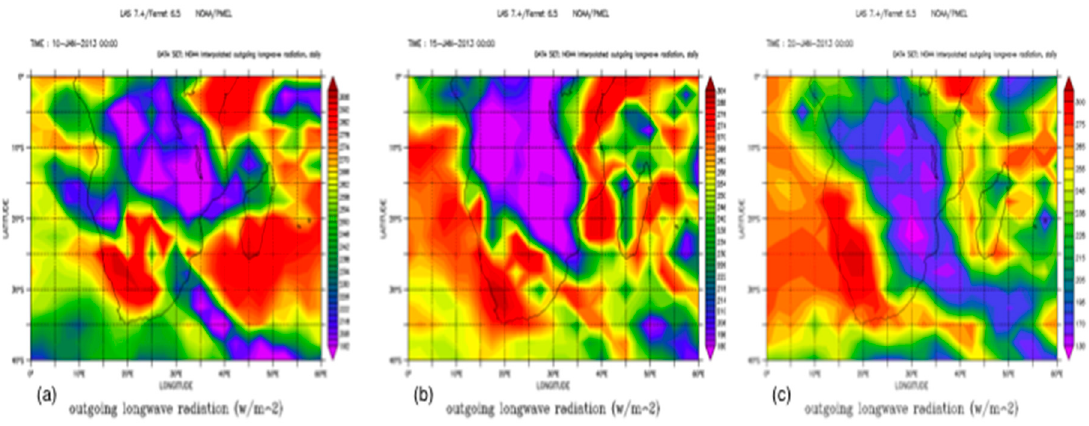
Figure 7. Outgoing longwave radiation (W m − 2 ) (http://apdrc.soest.hawaii.edu/las/v6/constrain?var=16121). Outgoing longwave radiation over southern Africa on 10 ( a ), 15 ( b ) and 20 ( c ) January 2013. Consistent with Figure 1, Figure 8 also shows IR brightness temperature between 15 and 20 January. Brightness temperature is one established proxy for discerning the intensity of convective updrafts and the precipitation potential on the ground ([64], and references therein). Much of the landmass was characterized by negative temperature anomalies with some trail bands over the SWIO. Active and fast developing convective cells are present over tropical central Africa, mostly centered over Botswana / Zimbabwe (Figure 8a–c), becoming more pronounced over southern